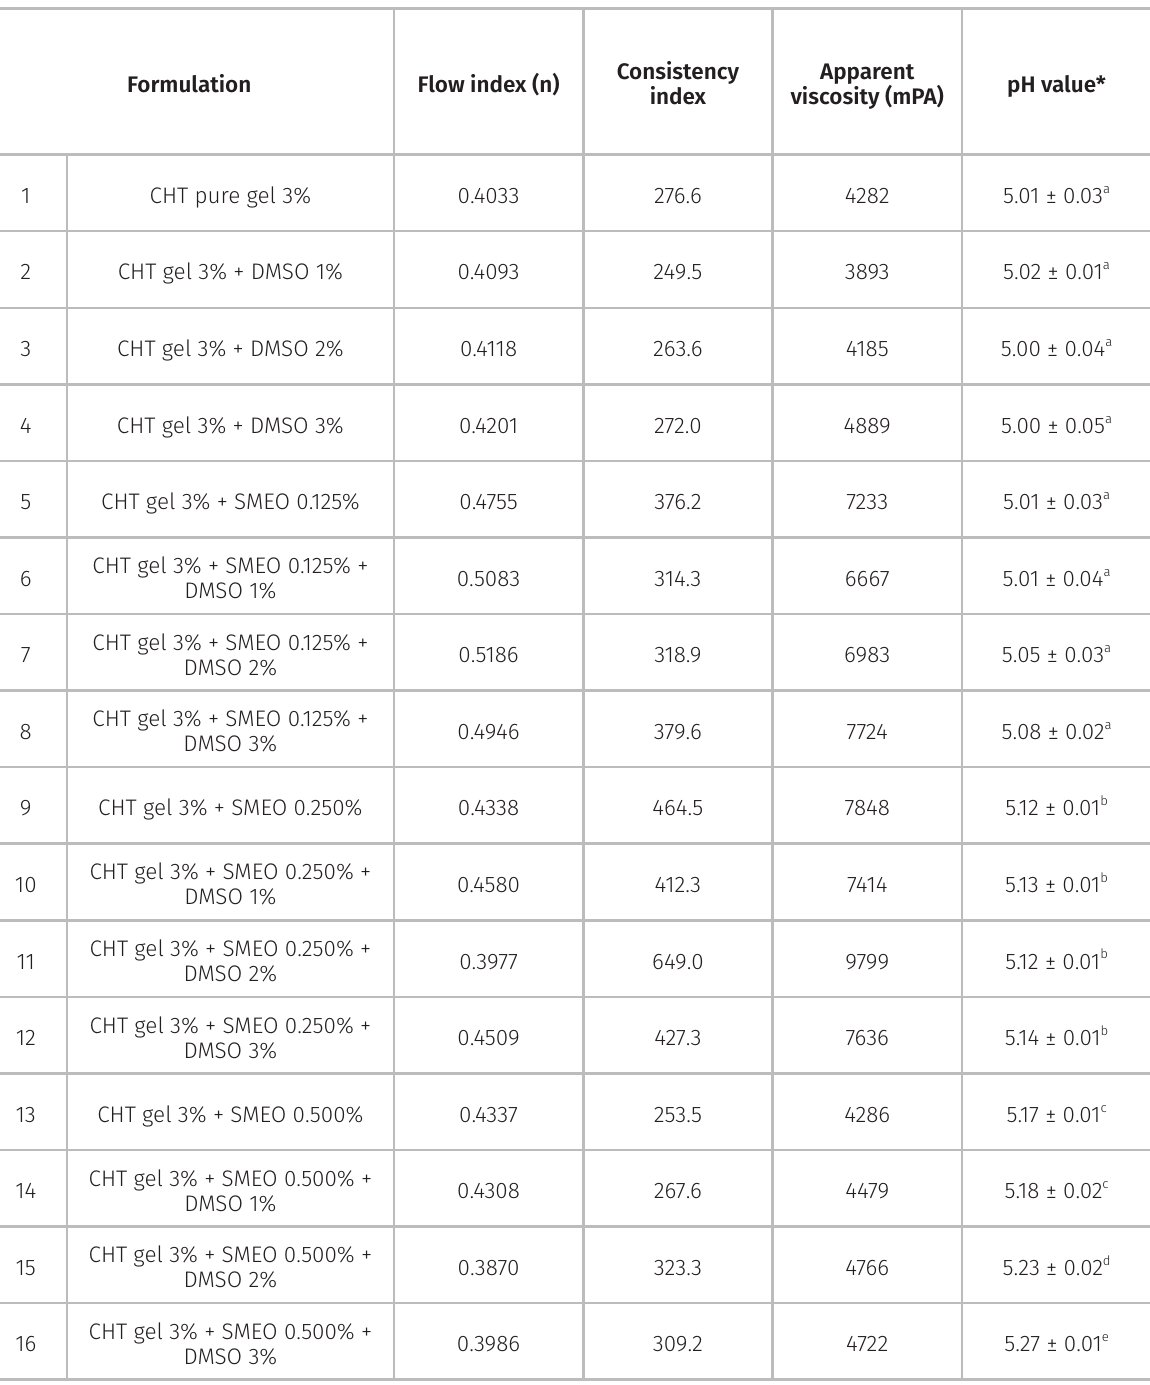
Table I. Rheological parameters and pH values in formulations containing chitosan gel 3% and different concentrations of Schinus molle essential oil and dimethyl